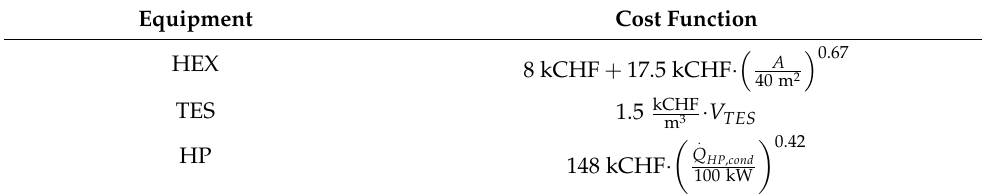
Table 5. Equipment cost functions for